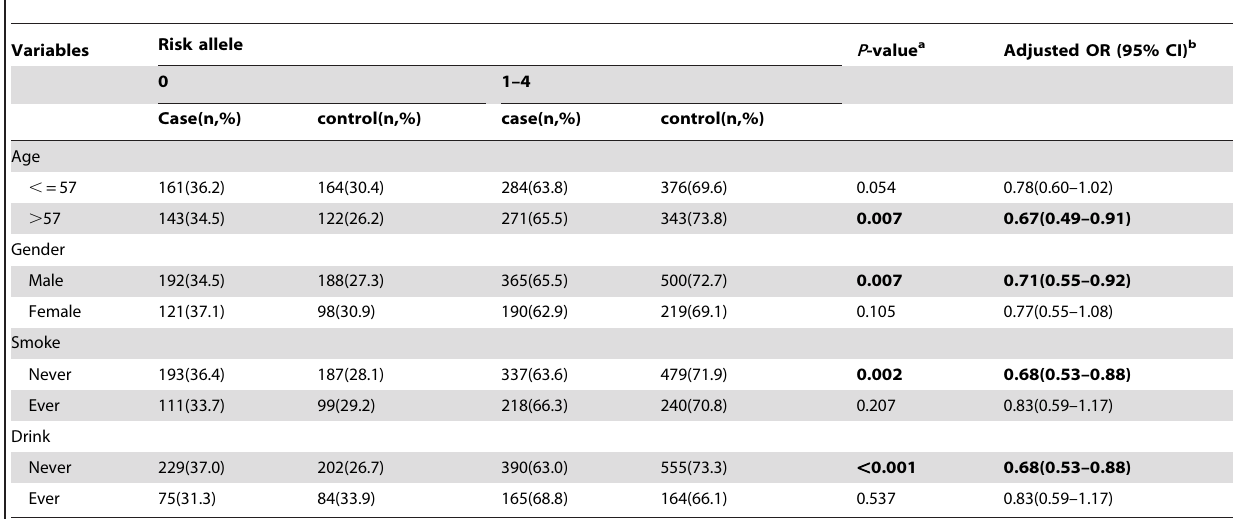
Table 5. Association between the combined genotypes of rs706209 and rs9332 polymorphisms and clear cell renal cell carcinoma in stratified